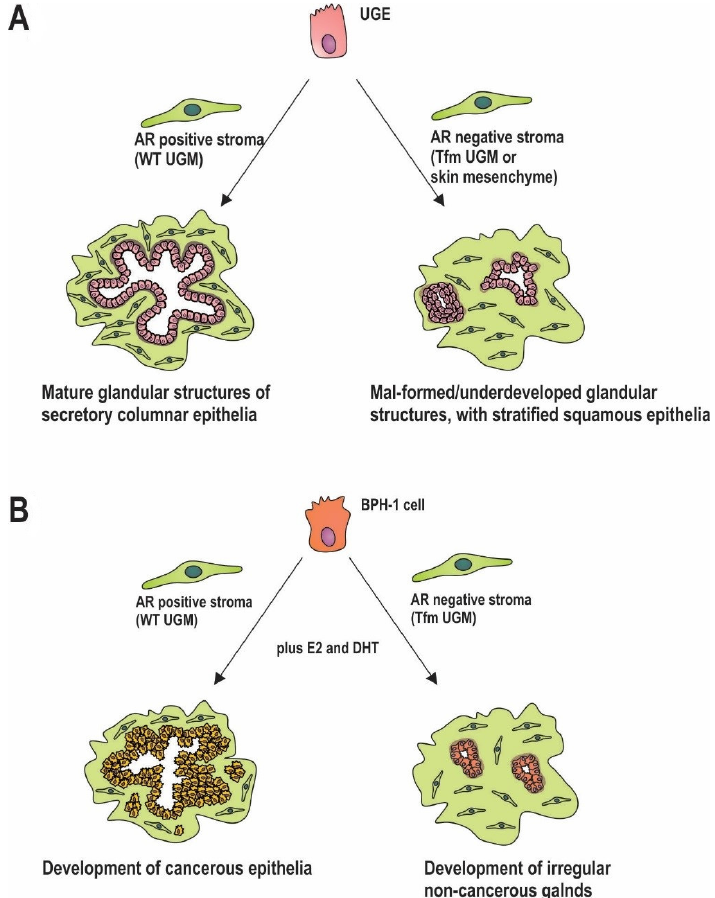
Figure 2. Impact of AR expression on prostate development and carcinogenesis. ( A ) Stromal AR is required for prostate development. In mouse models combining embryonic urogenital epithelia (UGE) with AR positive urogenital mesenchyme (UGM) results in normal epithelial structures, which doesn’t occur when UGE is combined with AR negative or non-functionally AR containing